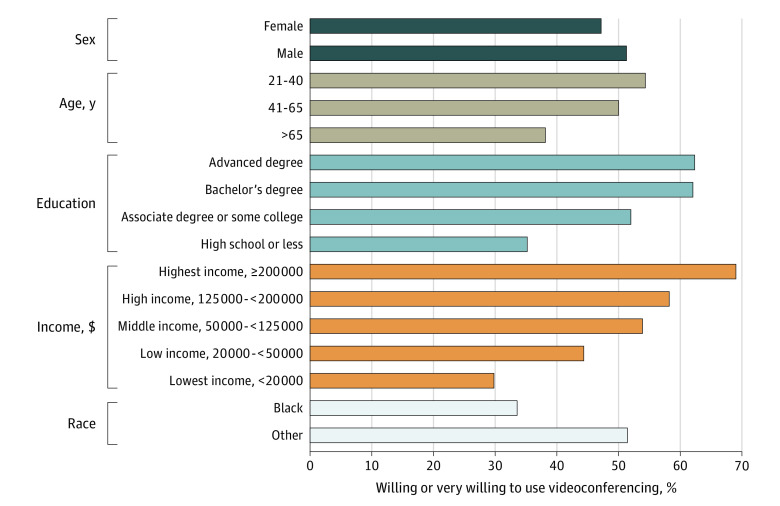
Univariate Comparisons of Willingness to Use Videoconferencing by Demographic CharacteristicComparison for sex P < .05; all other comparisons P < .001.